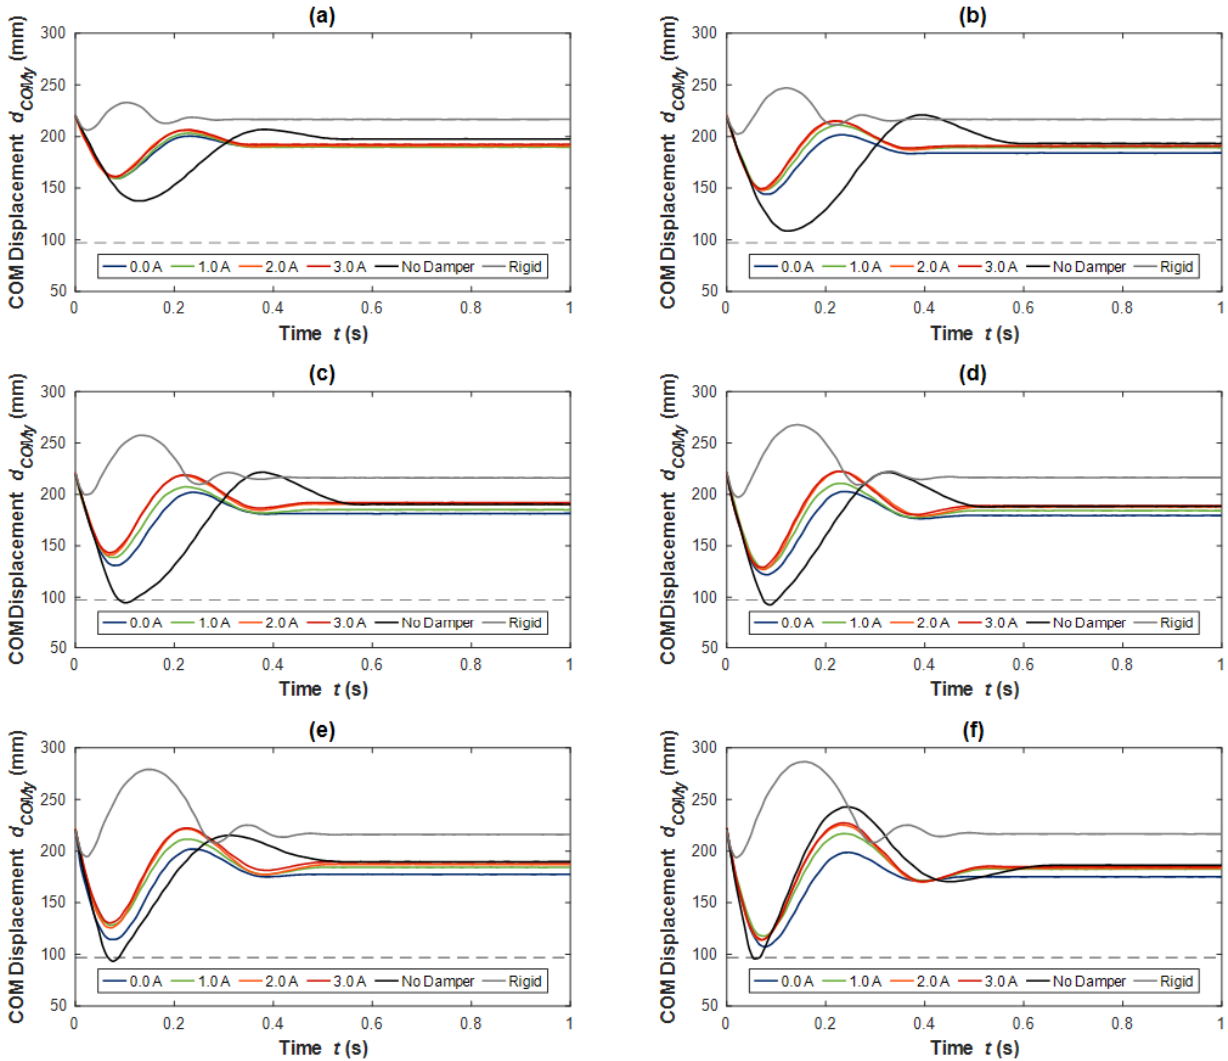
Figure 4. COM displacement for impact tests with a 2.65 kg total mass for drop heights of ( a ) 100 mm, ( b ) 200 mm, ( c ) 300 mm, ( d ) 400 mm, ( e ) 500 mm, and ( f ) 600 mm.